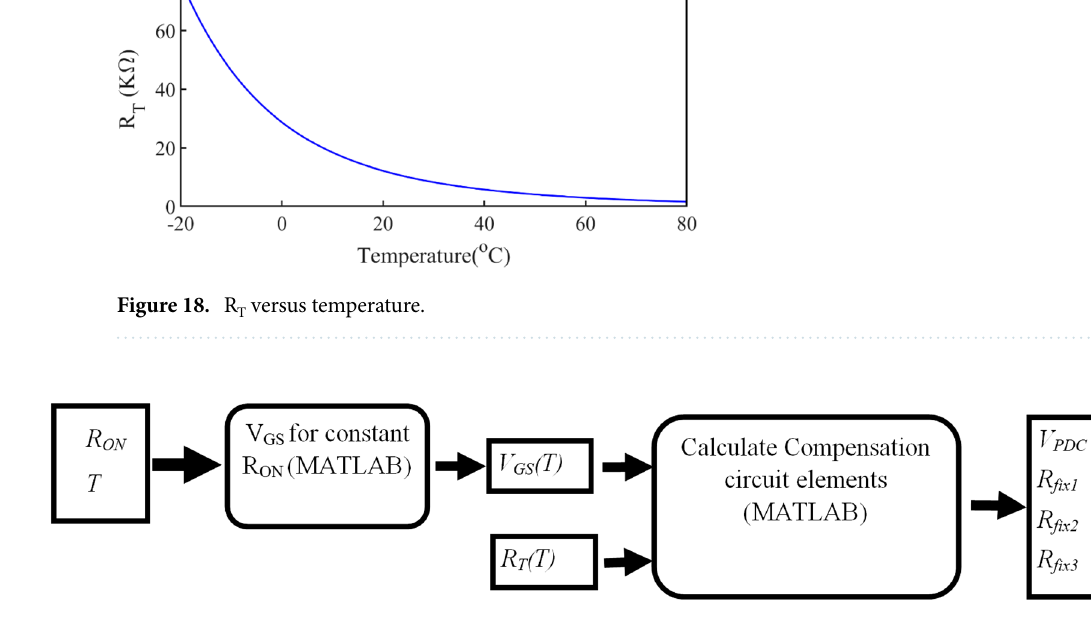
Figure 19. Block diagram of the TCU design flow.